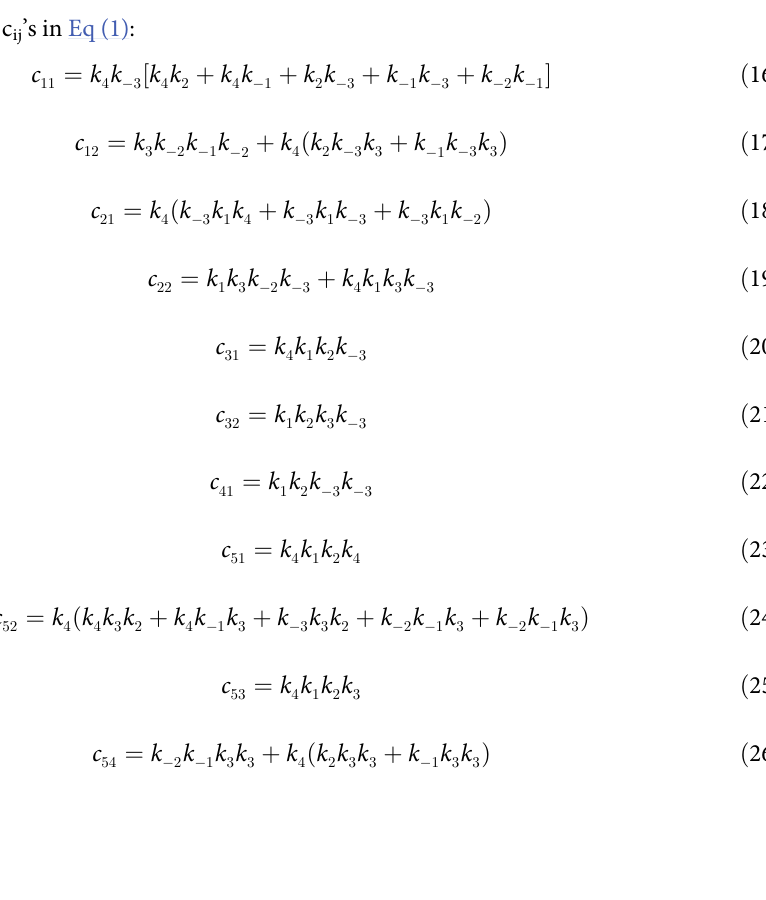
S2 Fig. General model for sirtuin-catalyzed deacylation in the presence of NAD +